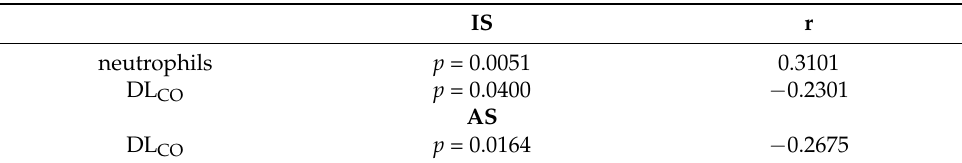
Table 4. Significant correlations between HRCT scores and neutrophils differential cell